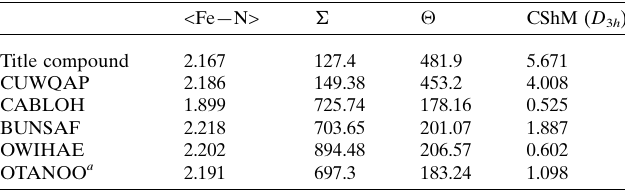
Table 2 Comparison of the distortion parameters (A˚ , (cid:4) ) for indicated Fe II complexes.